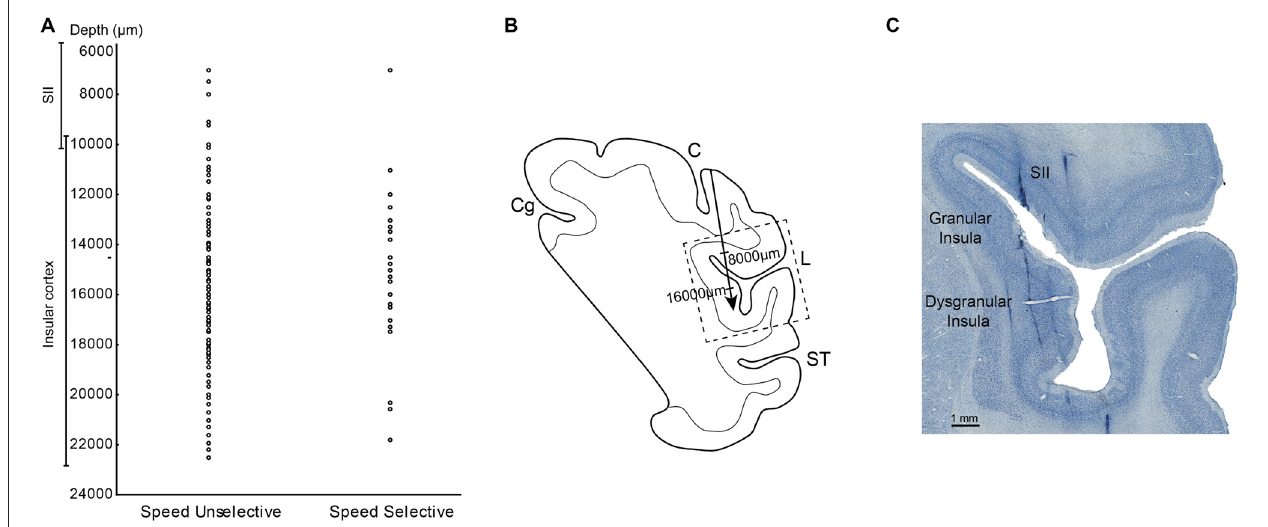
FIGURE 6 | (A) Distribution of the SS and SU neurons in relation of the depths. (B) Drawing of the section in which the dashed box indicates the location of the photomicrograph in (C) . The arrow indicates the depth of track showed in (C). (C) High power photomicrograph of Nissl section from the right hemisphere in which it is possible to identify tracks of the recording electrode through the insular cortex and SII region. Abbreviations: L, lateral fissure; SII, secondary somatosensory cortex; ST, temporal sulcus; C, central sulcus.